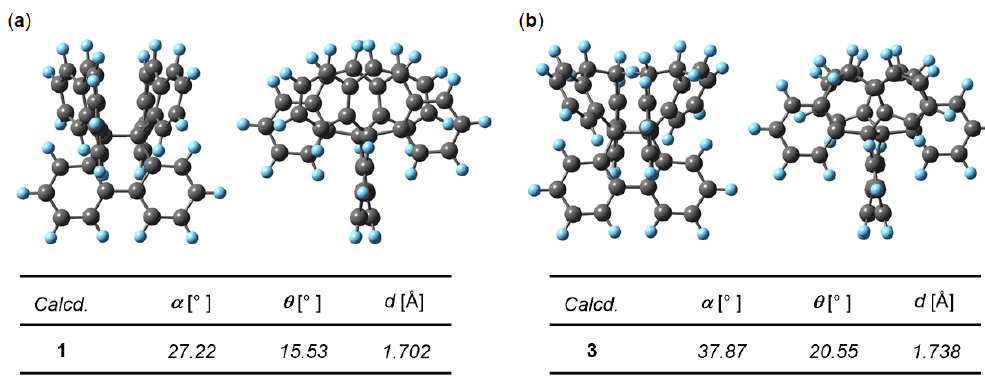
Figure 4. Optimized structures (left: front view, right: side view) of ( a ) 1 and ( b ) 3 .